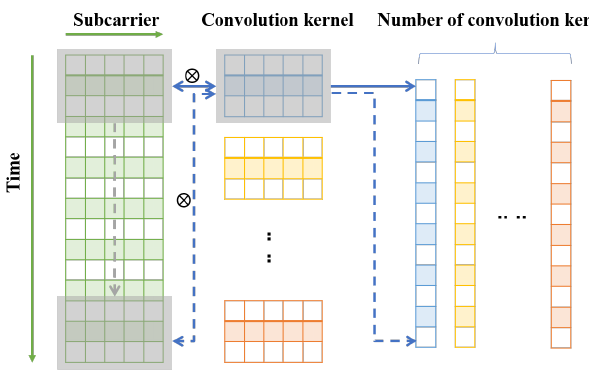
Figure 7. One-dimensional convolution